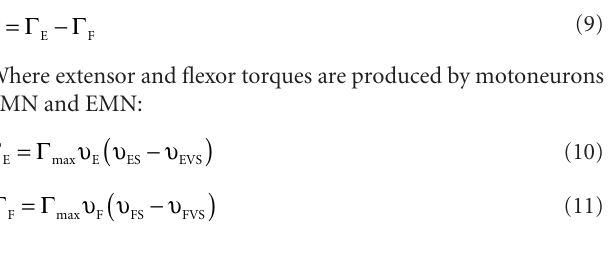
FiguRe 4 | The CPg model for one articulation. Proprioceptive inputs come from the angular position of the articular joint. RNF and RNE are Rowat– Selverston rhythmic neurons (flexor and extensor). EMN and FMN are extensor and flexor motor neurons, ESN and FSN are extensor, and flexor sensory neurons. VFSN and VESN are the velocity extensor and flexor sensory neurons.